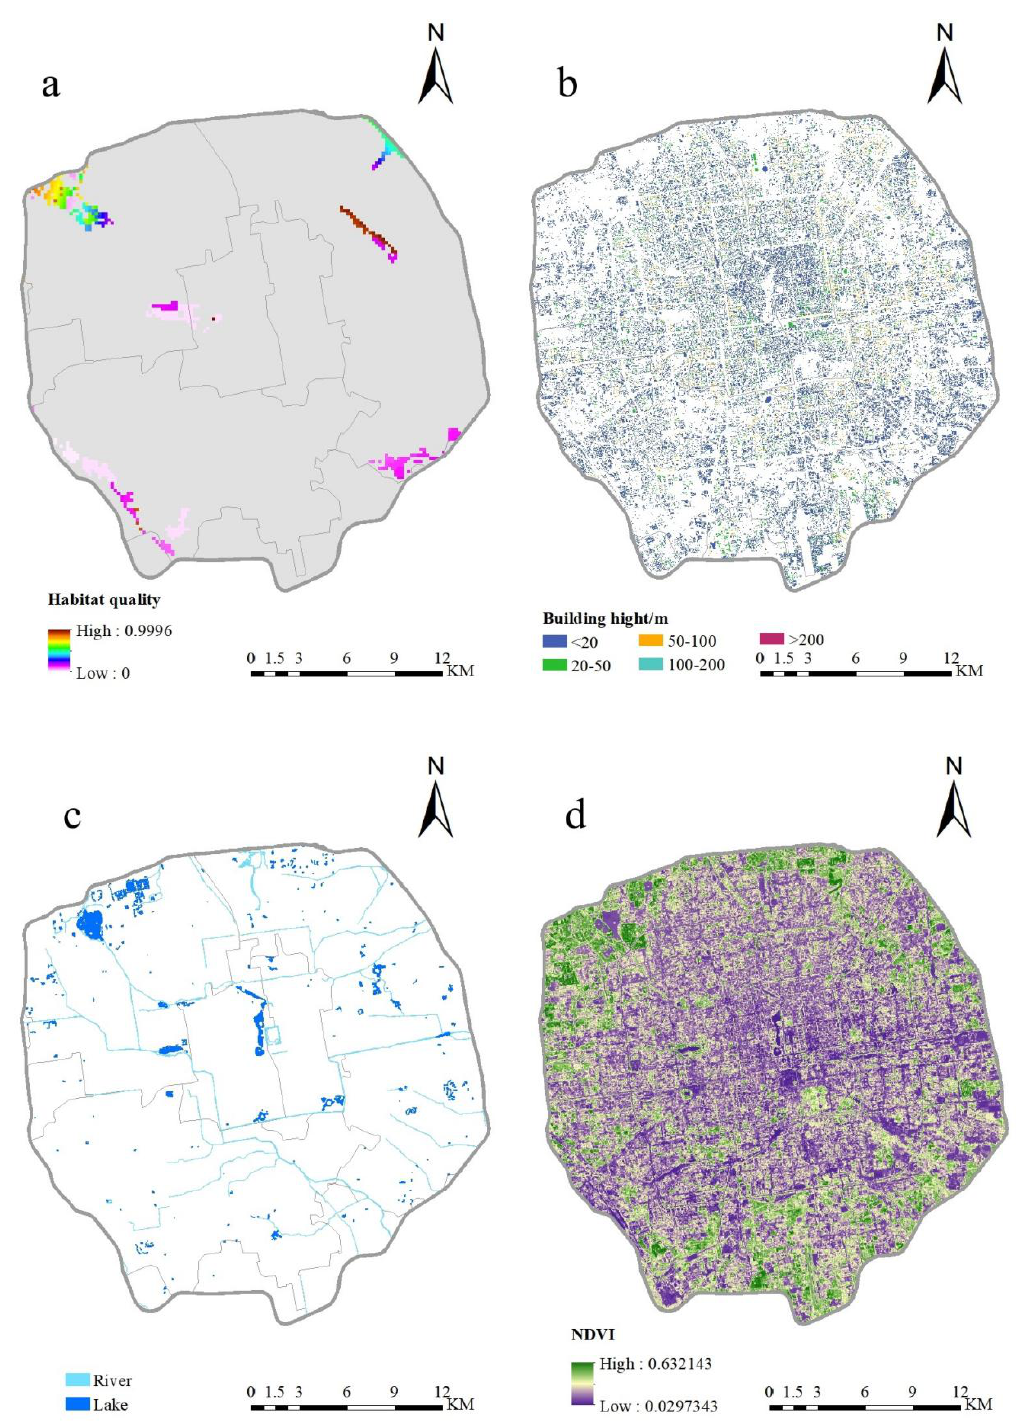
Figure 3. Spatial pattern of ecological source evaluation index in the study area. Note: ( a ): habitat quality, ( b ): building height, ( c ): water, ( d ): NDVI.